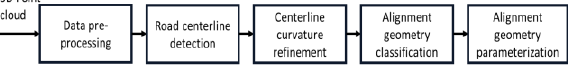
Figure 2. Point cloud labelling on training set (a) and test set (b): each point is labelled defining four classes: asphalt (blue), road markings (green), road signs (yellow), other (red).